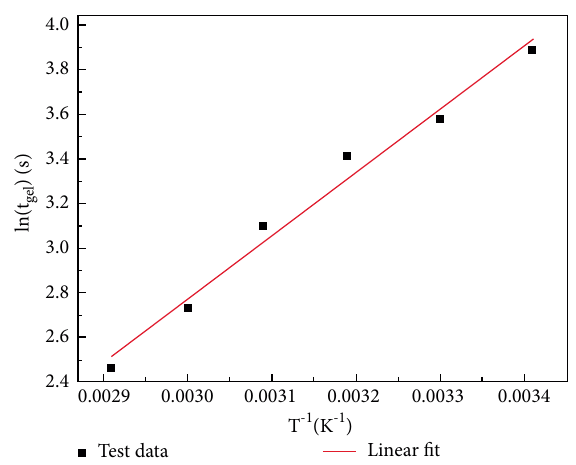
Figure 9: Arrhenius relationship of curing reaction of resin anchorage agent A.